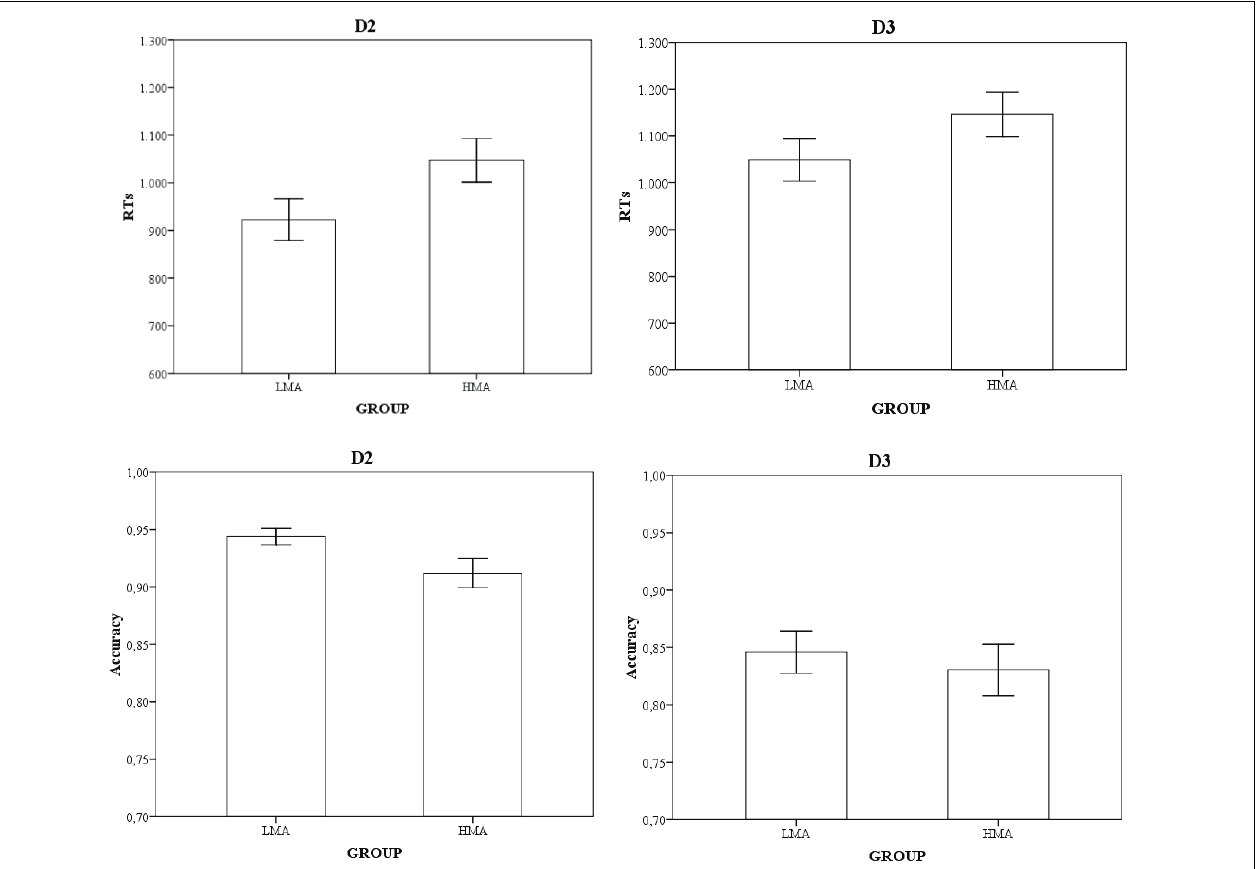
FIGURE 2 | Means and standard errors (in bars) for reaction times (in ms and upper row) and the proportion of hits (lower row) for each unordered sequence (D2 and D3) and math anxiety